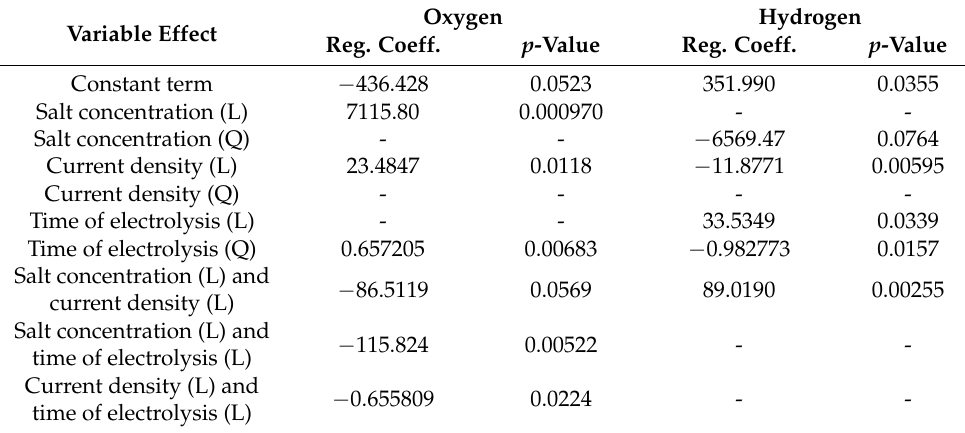
Table 4. Regression coefficients and corresponding p -values for the refined statistical model for both oxygen and hydrogen bubbles. L represents the linear effect; Q represents the quadratic effect. Two-factor effects are shown as a combination of two other numbered